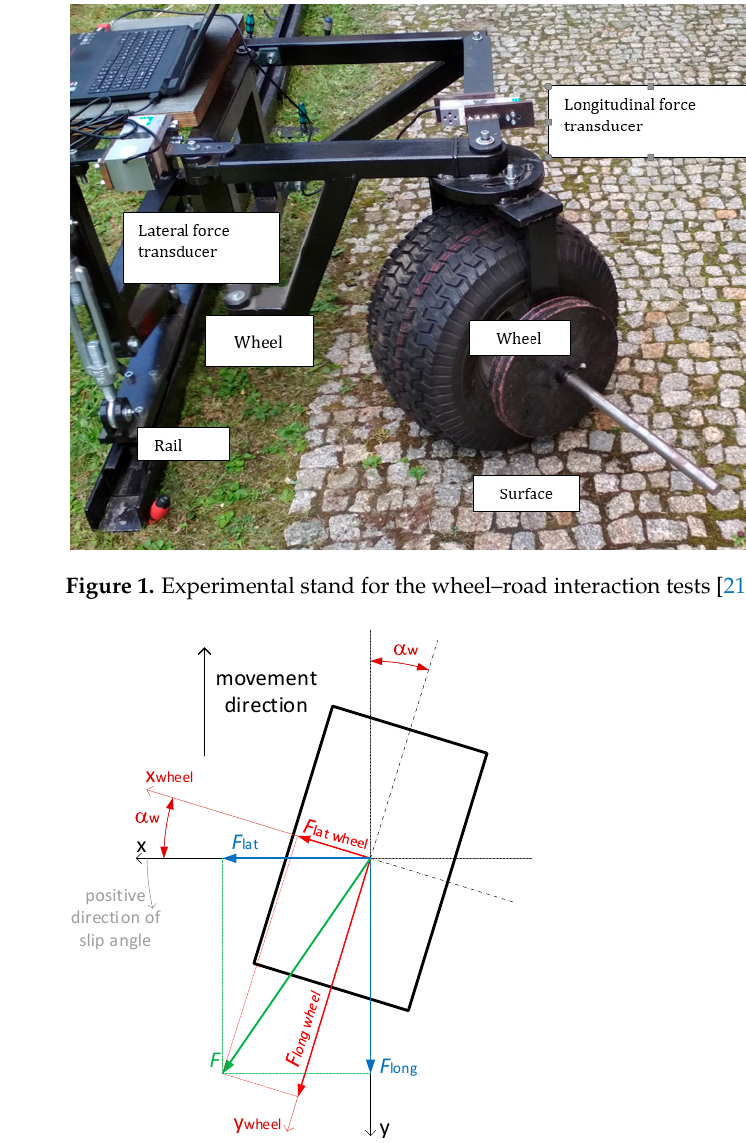
Figure 2. Top view of the geometrical model of the wheel.